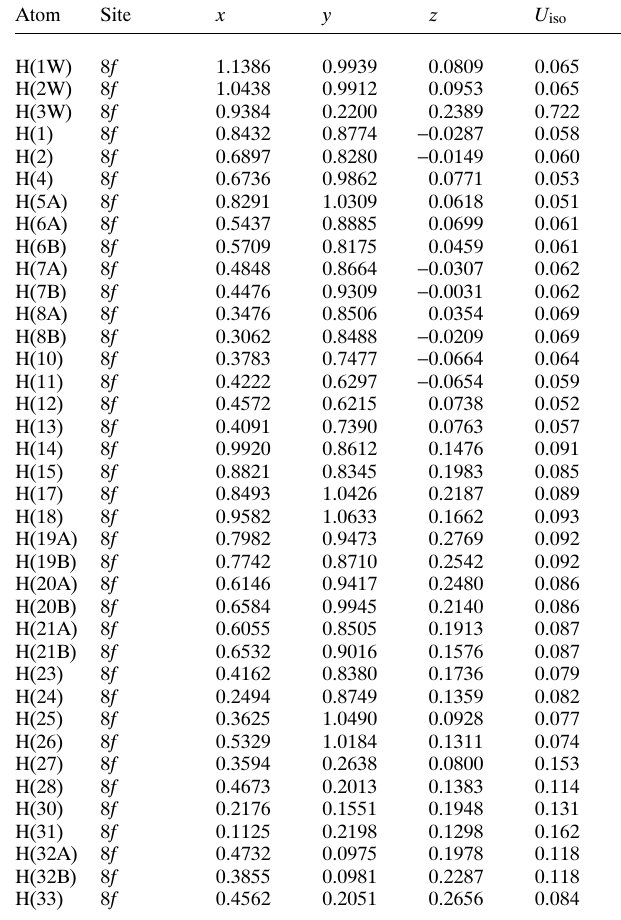
Table 2. Atomic coordinates and displacement parameters (in Å 2 ) .